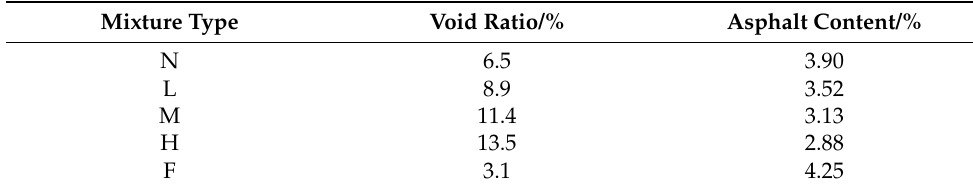
Table 2. Void ratio and asphalt content of AC-20 segregated mixtures.